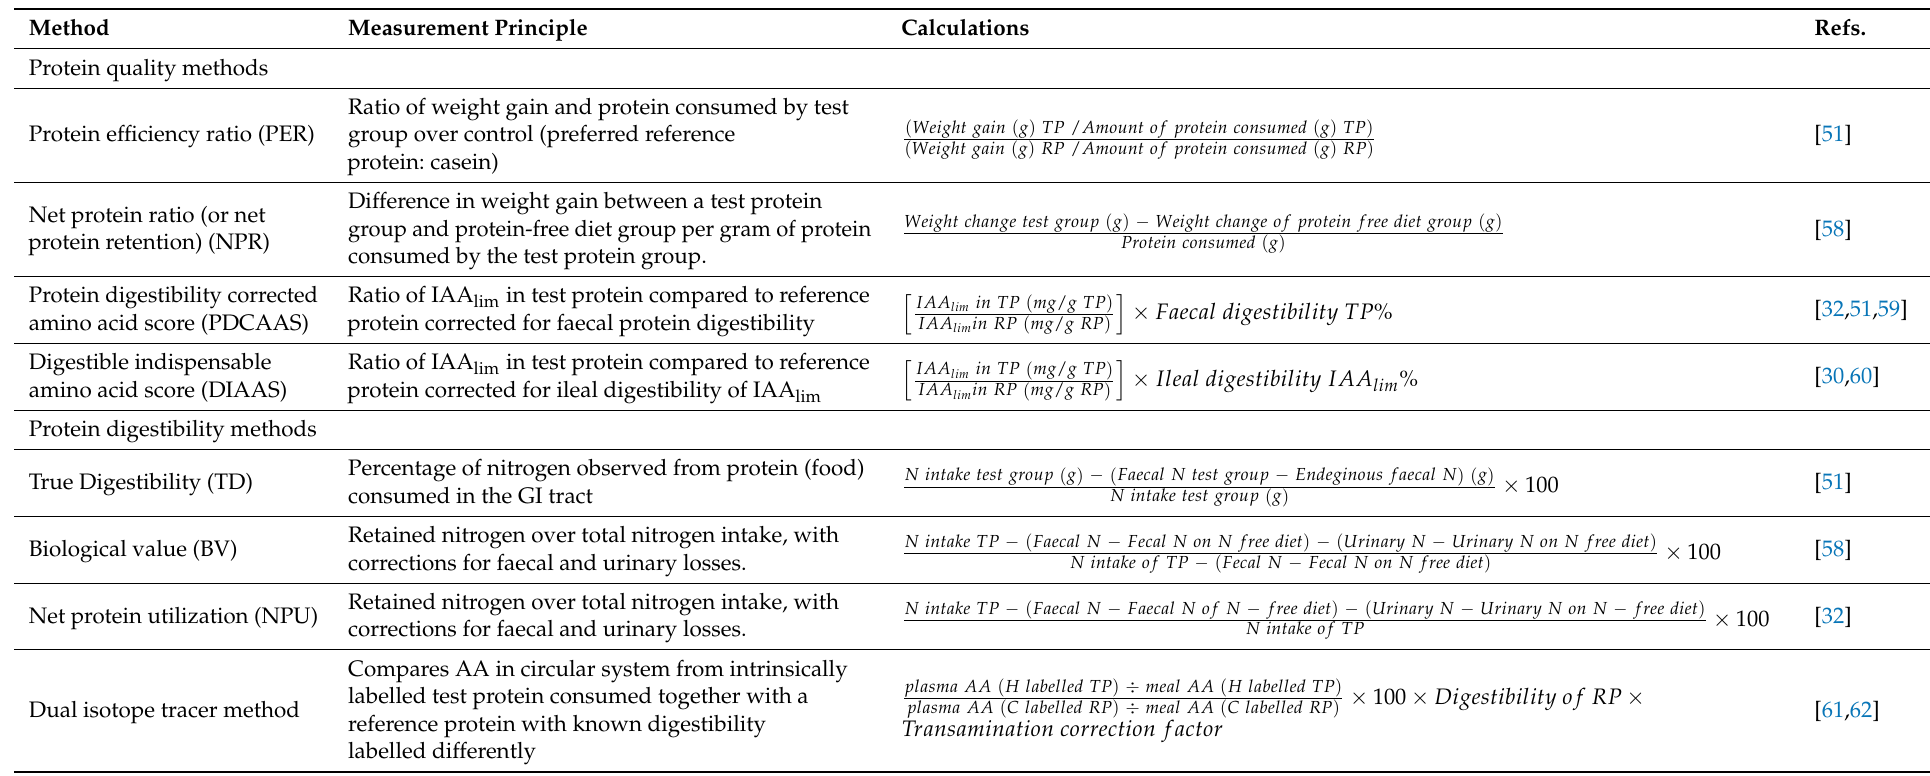
Table 3. Overview of in vivo methods used for determining protein quality and protein